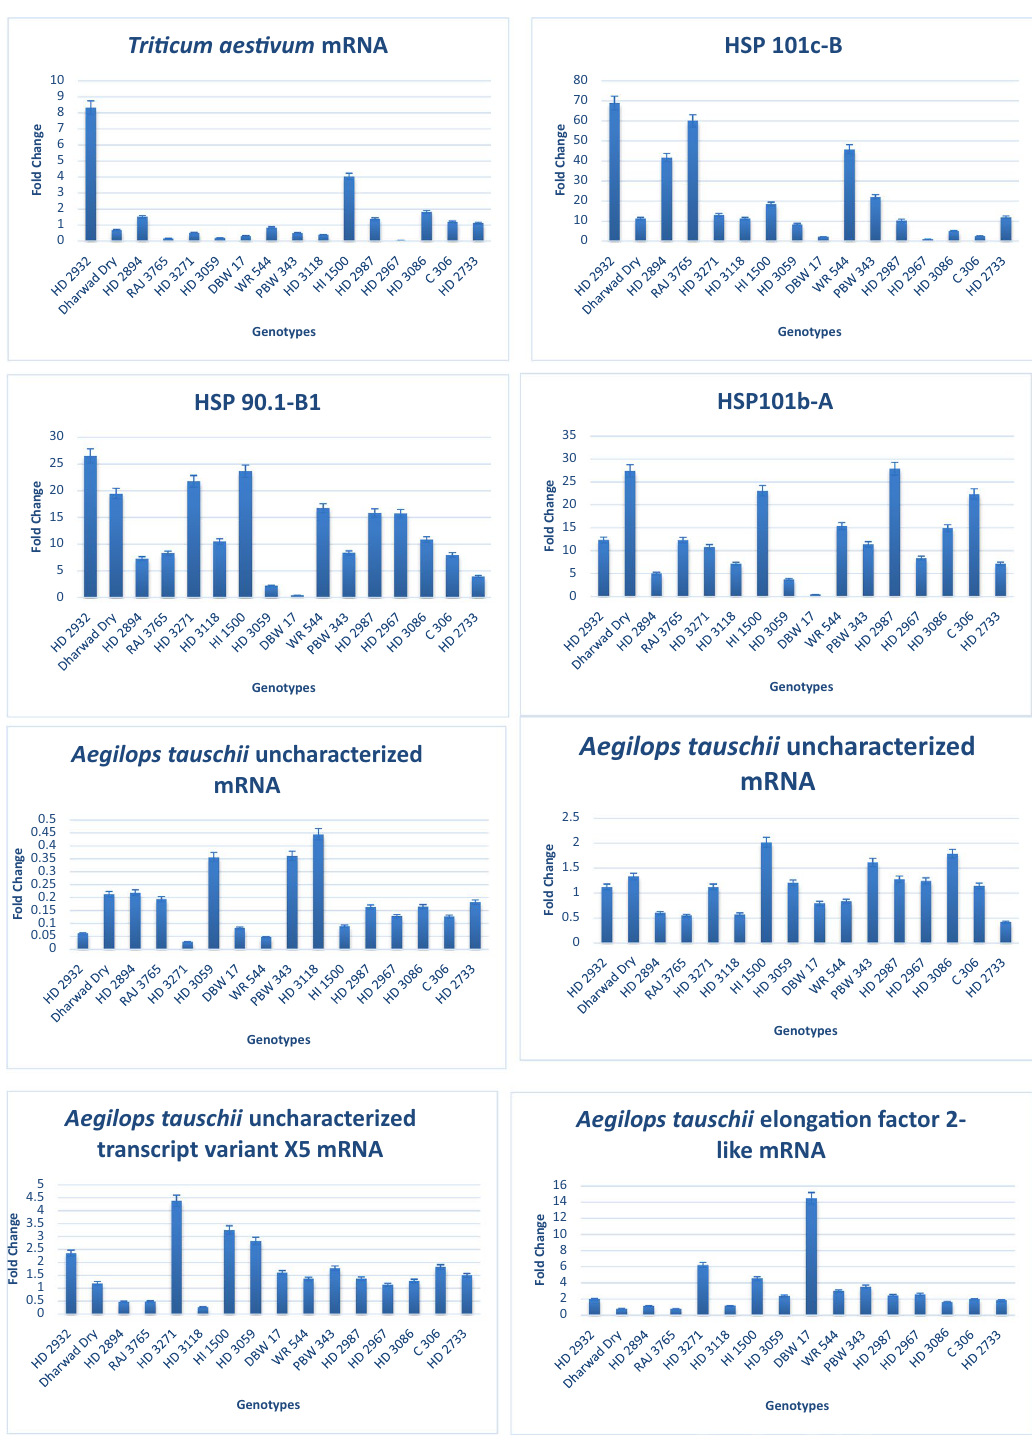
Figure 8. Validation and expression of eight selected genes detected by real time-quantitative PCR (RT-qPCR). Gene expression levels were normalized to the internal control TaActin